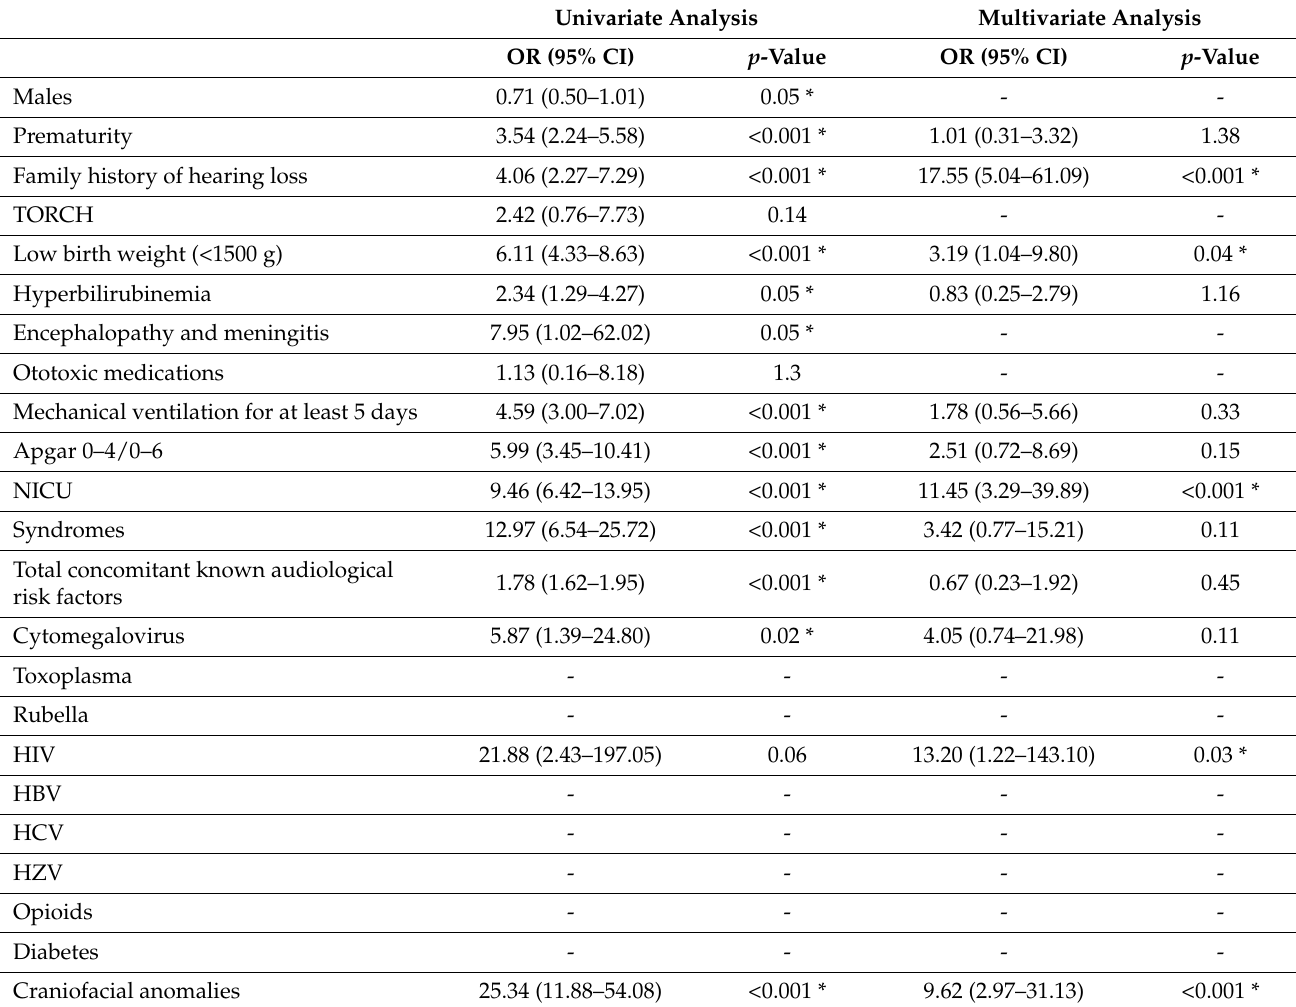
Table 4. Logistic regression analysis to assess the relationship between clinical characteristics and hearing loss. Statistically significant values are marked with an asterisk *. OR = odds